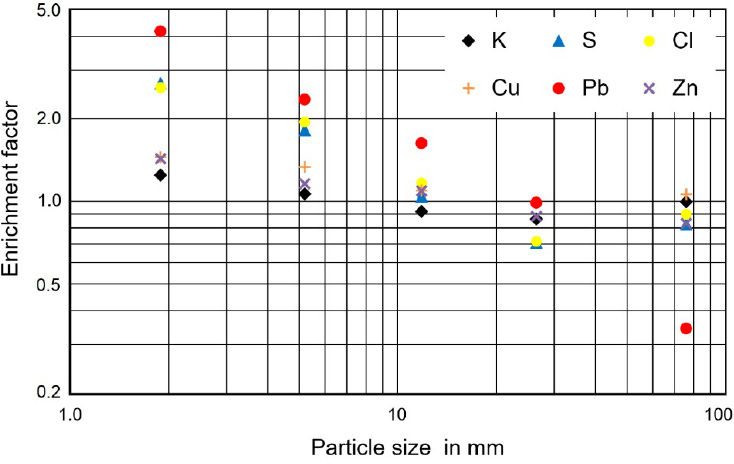
Figure 3. Size dependence of the concentration of various components.